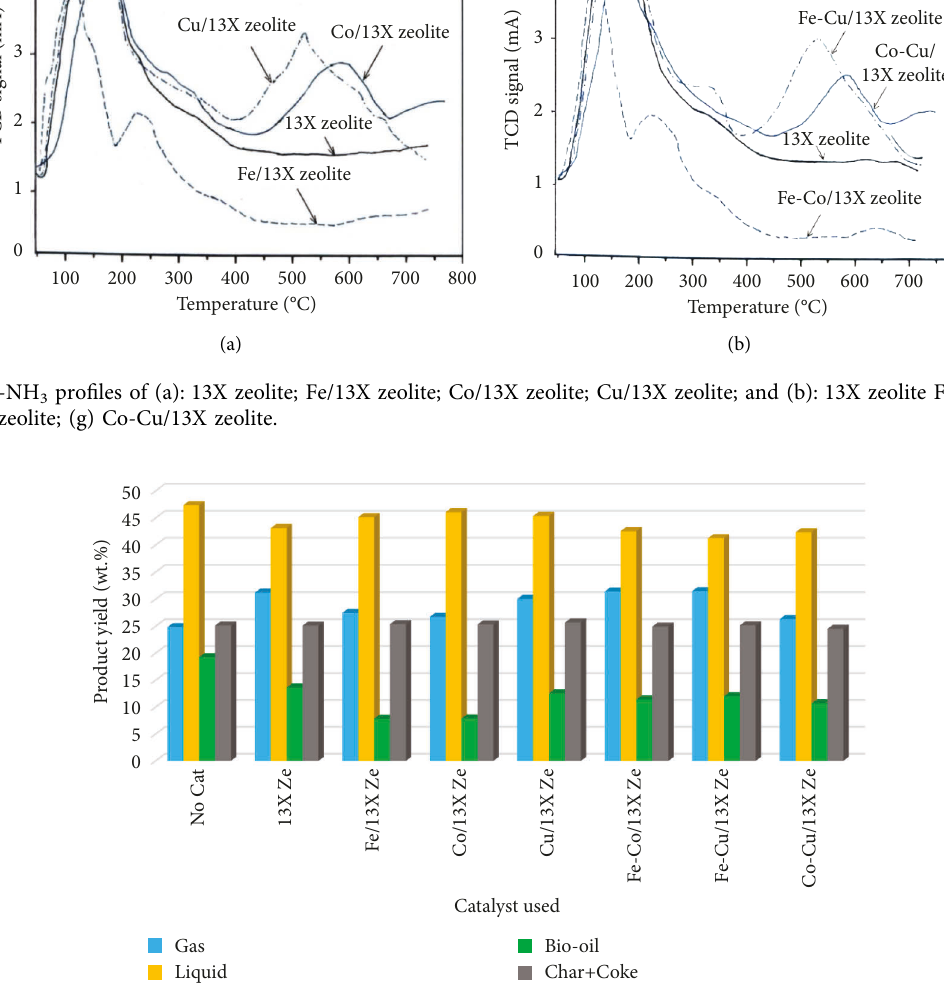
Figure 8: Effect of the metal-modified 13X zeolite catalysts on the distribution of products resulted by RRB pyrolysis.